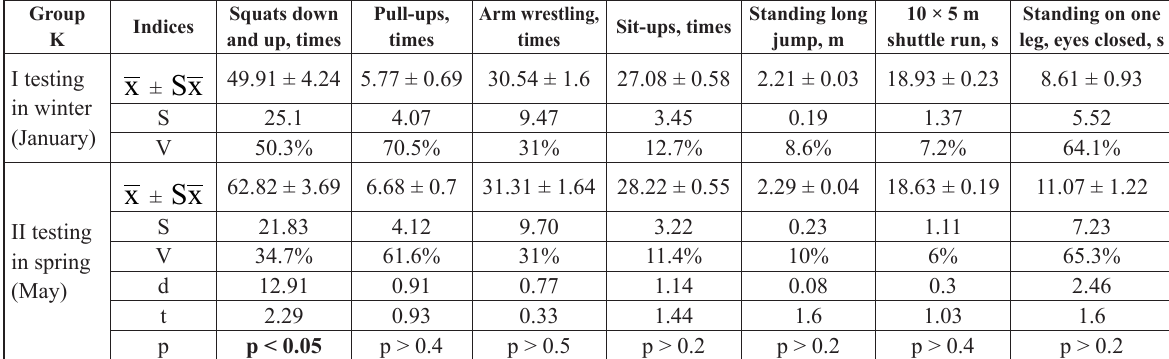
Note. p — statistical evaluation of difference between fi rst and third testing ( x )